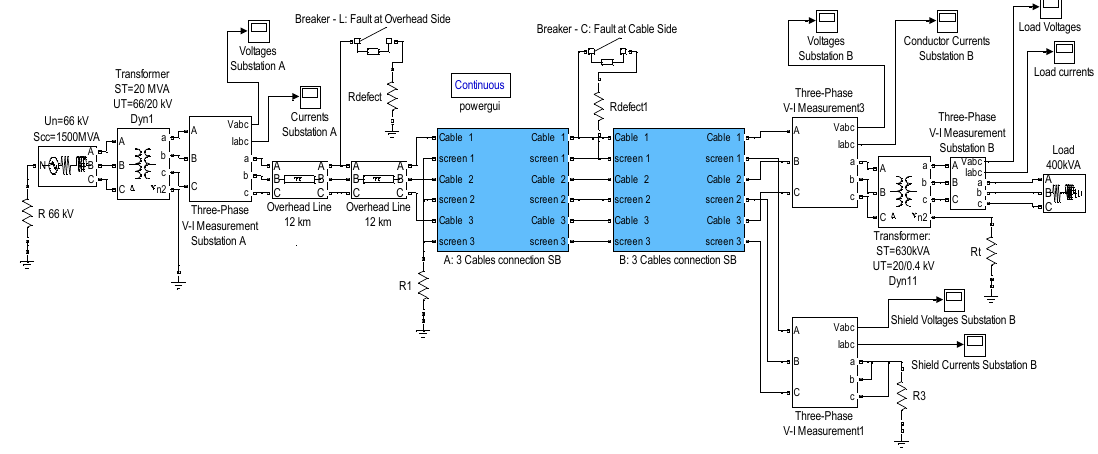
Figure 9. New auto-reclosing blocking method: model implemented.